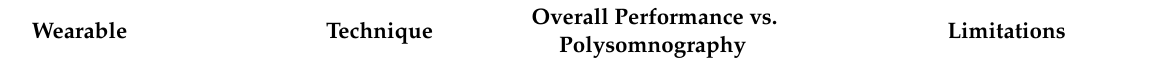
Table 2. Wearable sleep-trackers dedicated to sleep measurement in healthy subjects.